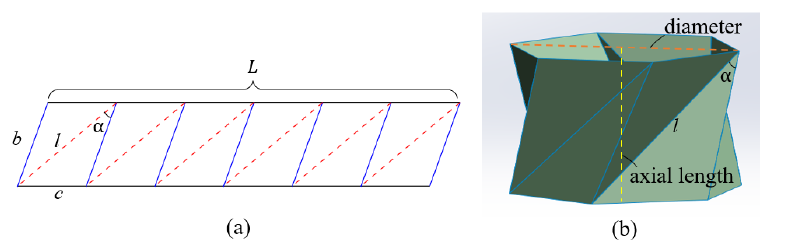
Figure 4. Generic Kresling pattern. ( a ) Kresling pattern in a planar form. ( b ) Three-dimensional state of the Kresling structure. ( n =